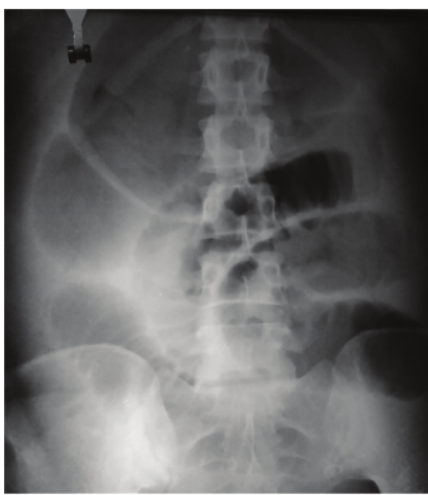
Figure 1: Plain abdominal radiograph with dilated colon.